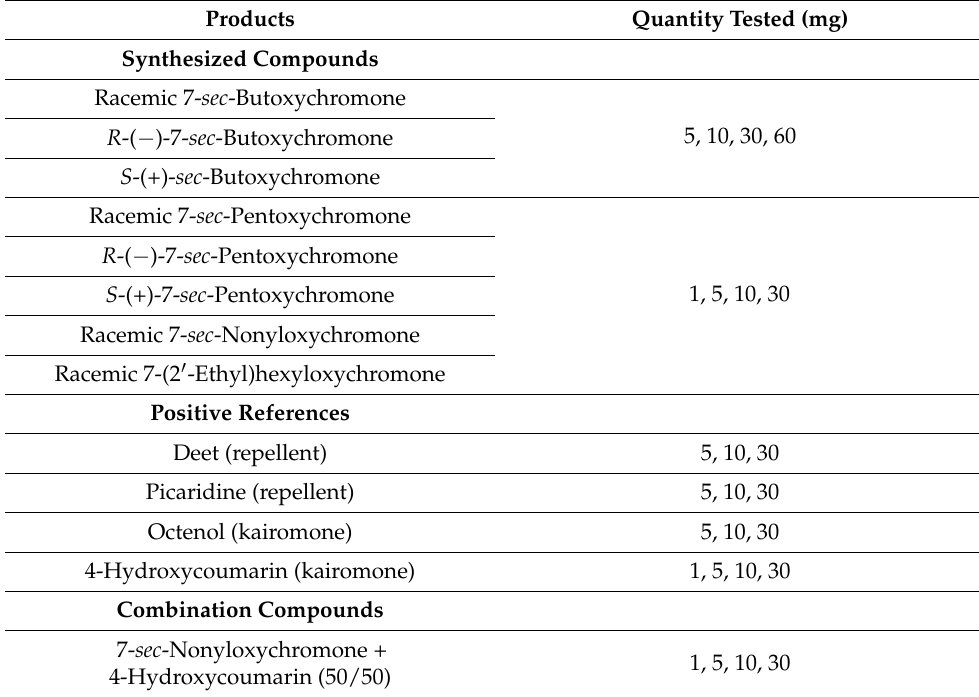
Table 3. List of tested products and their quantities deposited on filter